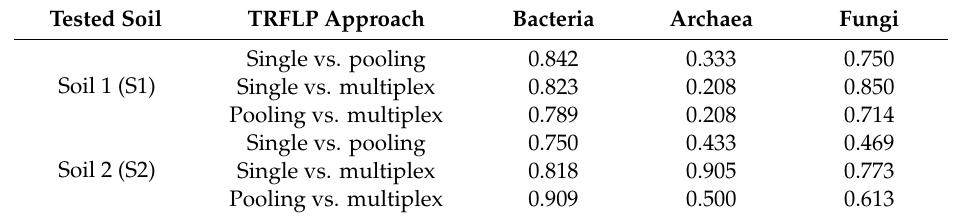
Table 4. Jaccard’s coe ffi cient (J) * between the restriction profile obtained for various t-RFLP approaches. Tested Soil TRFLP Approach Bacteria Archaea